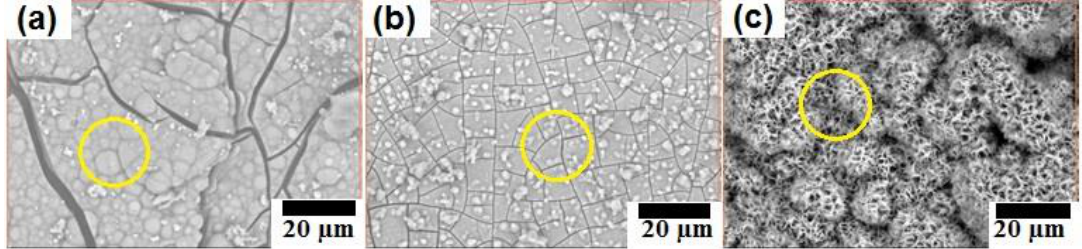
Figure 6. SEM images of immersed samples: ( a ) B-1; ( b ) B-2; and ( c ) C-2.